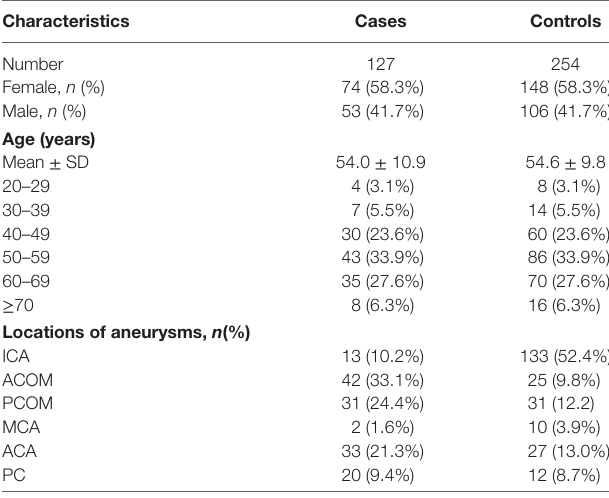
TaBle 1 | Distribution of age, sex, and locations of cases and